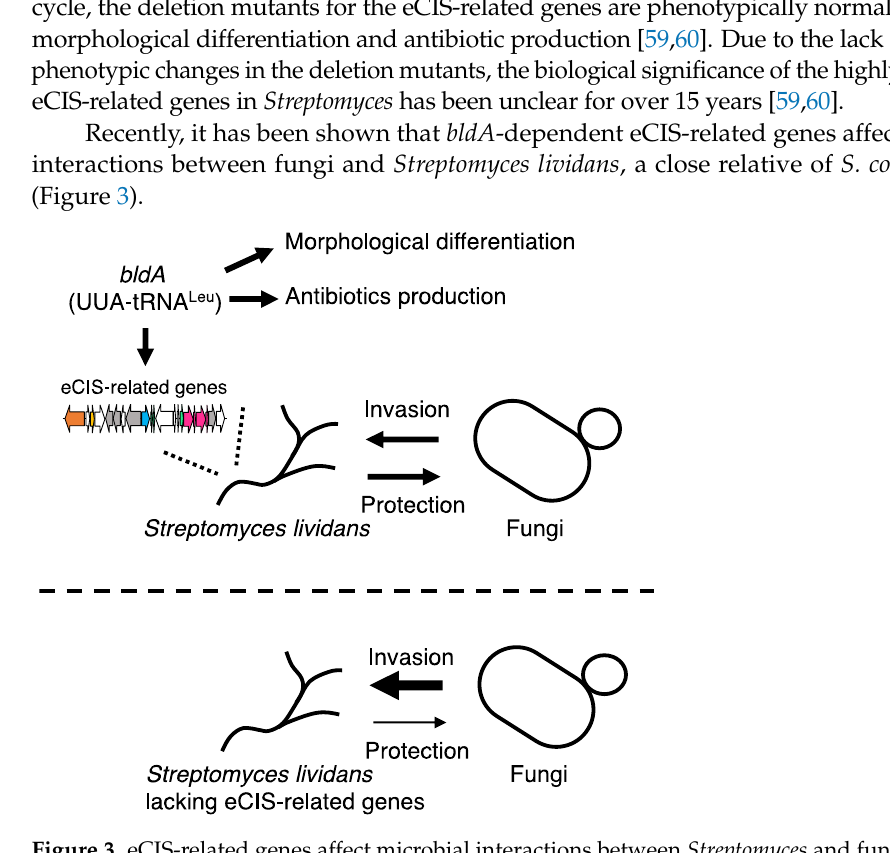
Figure 3. eCIS-related genes affect microbial interactions between Streptomyces and fungi. Schematic models indicating the competition between Streptomyces lividans and fungi mediated by eCIS-related genes. In S. lividans , eCIS-related genes are regulated by bldA , which also regulates morphological differentiation and antibiotic production in the bac- terium. The arrows denoted as “Invasion” and “Protection” indicate the invasion of fungal cells into S. lividans colony and the resistance of S. lividans colony to the fungal invasion, respectively. The arrow with the thin line in the bottom illustration indicates that S. lividans mutant colony is less resistant to fungal invasion than the parental strain, and the arrow with the thick line indicates that fungal cells can severely invade the S. lividans colony. The colonies of the deletion mutants of S. lividans for the eCIS-related genes are more severely invaded by fungi, such as Saccharomyces cerevisiae and Schizosaccharomyces pombe , than the parental strain [61] (Figure 3). The eCIS-related gene cluster is almost completely conserved among S. lividans and S. coelicolor , and gene deletion experiments confirmed that the bldA -dependent regulation of eCIS-related genes is a common mechanism among these species [61]. In addition, transmission electron microscopy images show that the products of these genes are phage tail-like nanostructures, which are similar to known gram-negative bacterial eCISs [45,61]. Based on these observations, the phage tail-like nanostructures found in S. lividans and S. coelicolor have been named Streptomyces phage tail-like particles (SLPs) [61] (Figure 3). Microscopic and transcriptional analyses demonstrated that SLP expression in S. lividans was upregulated upon co-culture with fungal competitors,